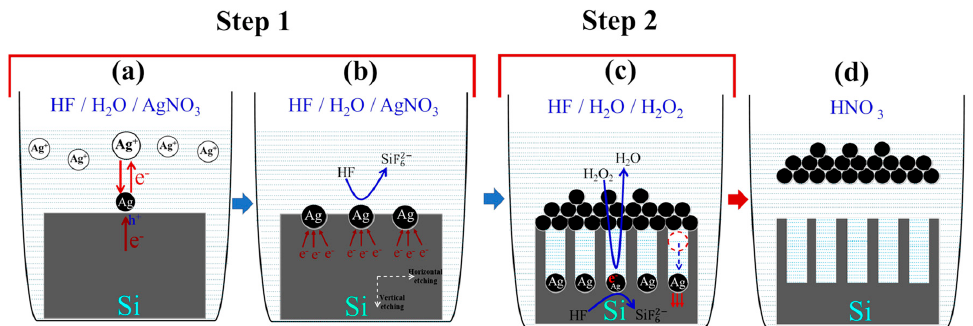
Figure 2. Schematic illustration of the formation mechanism of silicon nanowires (SiNWs) via two-step MACE. ( a ) Reduction of Ag + ions and formation of Ag nuclei at the Si surface. ( b ) Further silver nuclei growth, oxidative dissolution of Silicon atoms, and production of porous layer. ( c ) Vertical propagation of silver nanoparticles and faster etching leading to SiNWs formation. ( d ) Silver removal and vertical aligned SiNW arrays production.